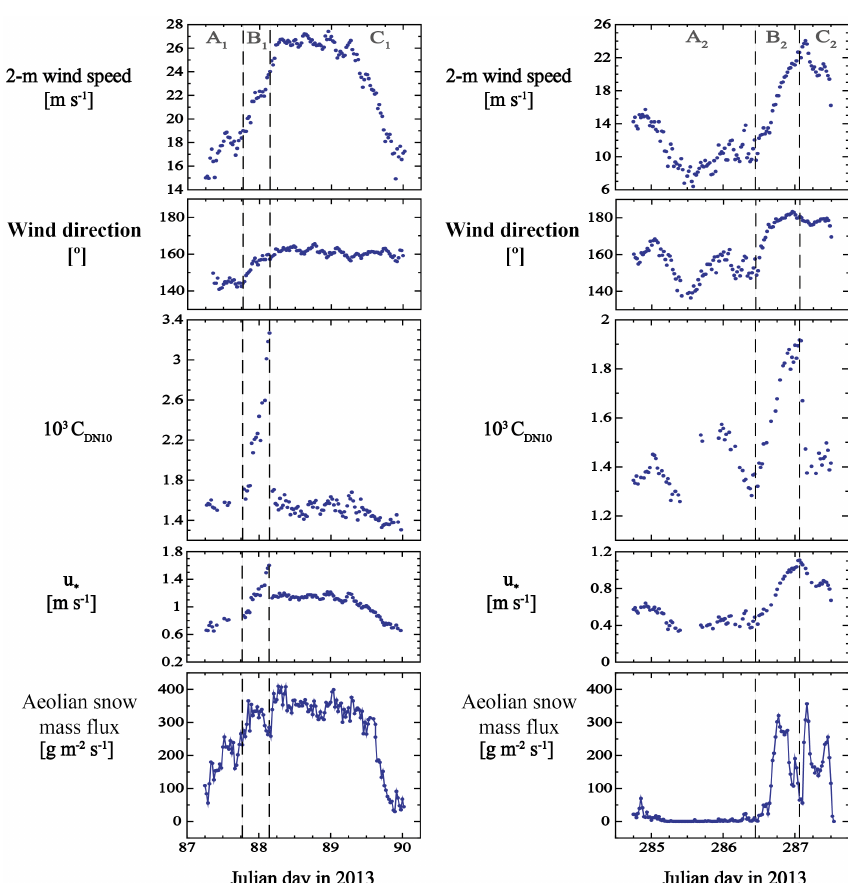
Figure 3. Two erosion events showing sastrugi responses to shifts in wind direction. Note the different vertical scales between right and left panels concerning measured 2m wind speed, profile-derived C DN10 and u ∗ values. In both cases, the event is split into three parts: before the wind shift (A i ) , during (B i ) and after (C i )